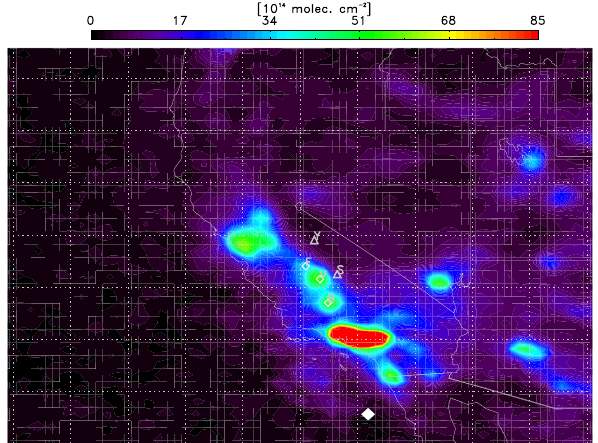
Fig. 9. Climatological (2005–2008) diurnal cycles of surface ozone mixing ratios at Fresno (Red) and Turtleback dome (Blue) in Yosemite National Park for the month of